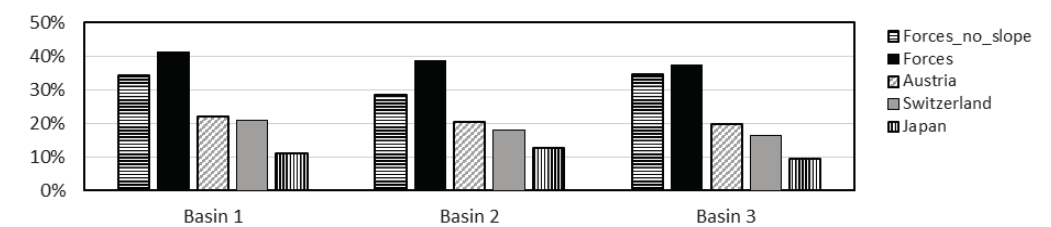
Fig. 6 Percentage of flood prone area affected by high hazard level (red